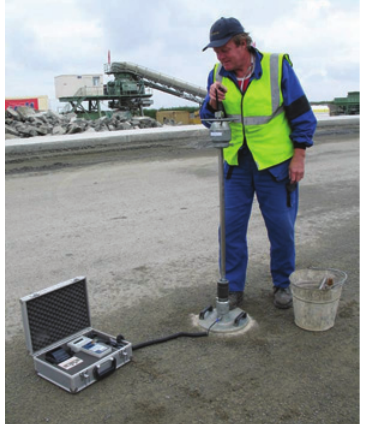
fig. 3. Dynamic plate loading test using LFWD